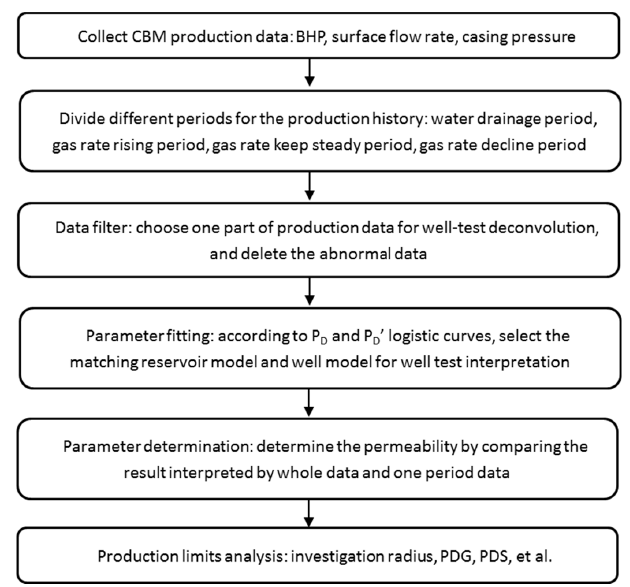
Figure 2. Procedure for CBM production dynamic analysis.